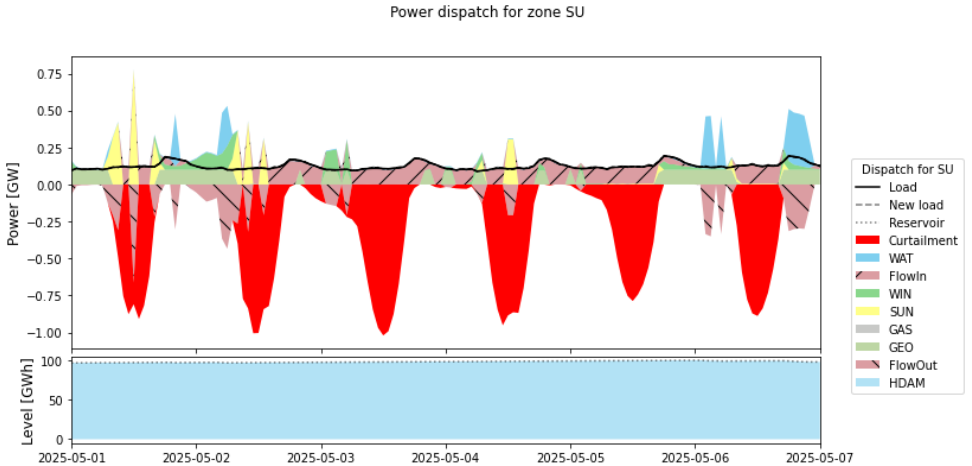
Figure 25. Very-High-Penetration Scenario 10(H)—South zone (1–7 May 2025).